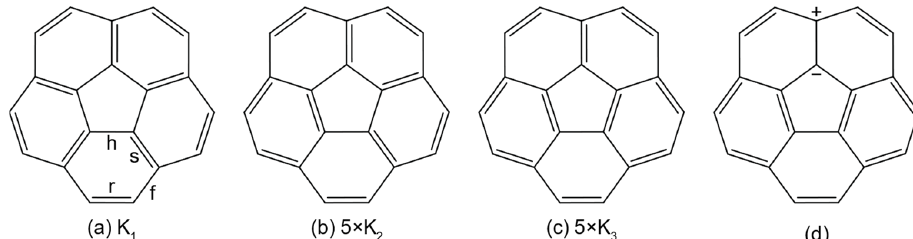
Figure 1. Kekulé ( a–c ) and one ionic resonance structure ( d ) for corannulene. The positions of the carbon–carbon hub (h), spoke (s), flank (f) and rim (r) bonds are shown in ( a ). The carbon atoms are referred to as hub (involved in two hub bonds), flank (involved in two flank bonds) and rim.